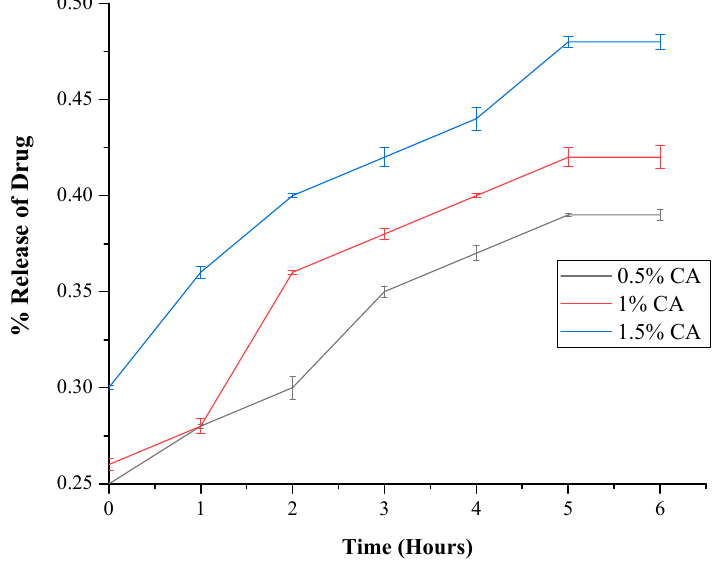
Figure 6. Drug release patterns of c-spun PCL-CA fibrous mats (CA: 0.5, 1, and 1.5%).